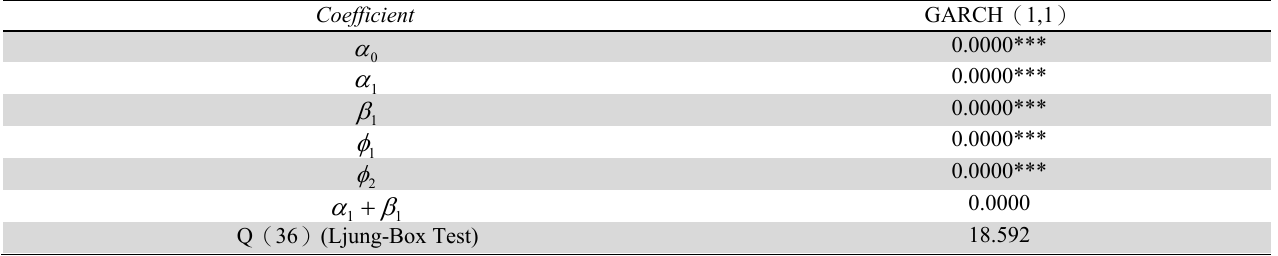
steel bars futures, and the test results are shown in Table 3: GARCH (1,1) model parameters of the price volatility (RT) and explanatory variables of deformed steel bars futures Coefficient GARCH （ 1,1